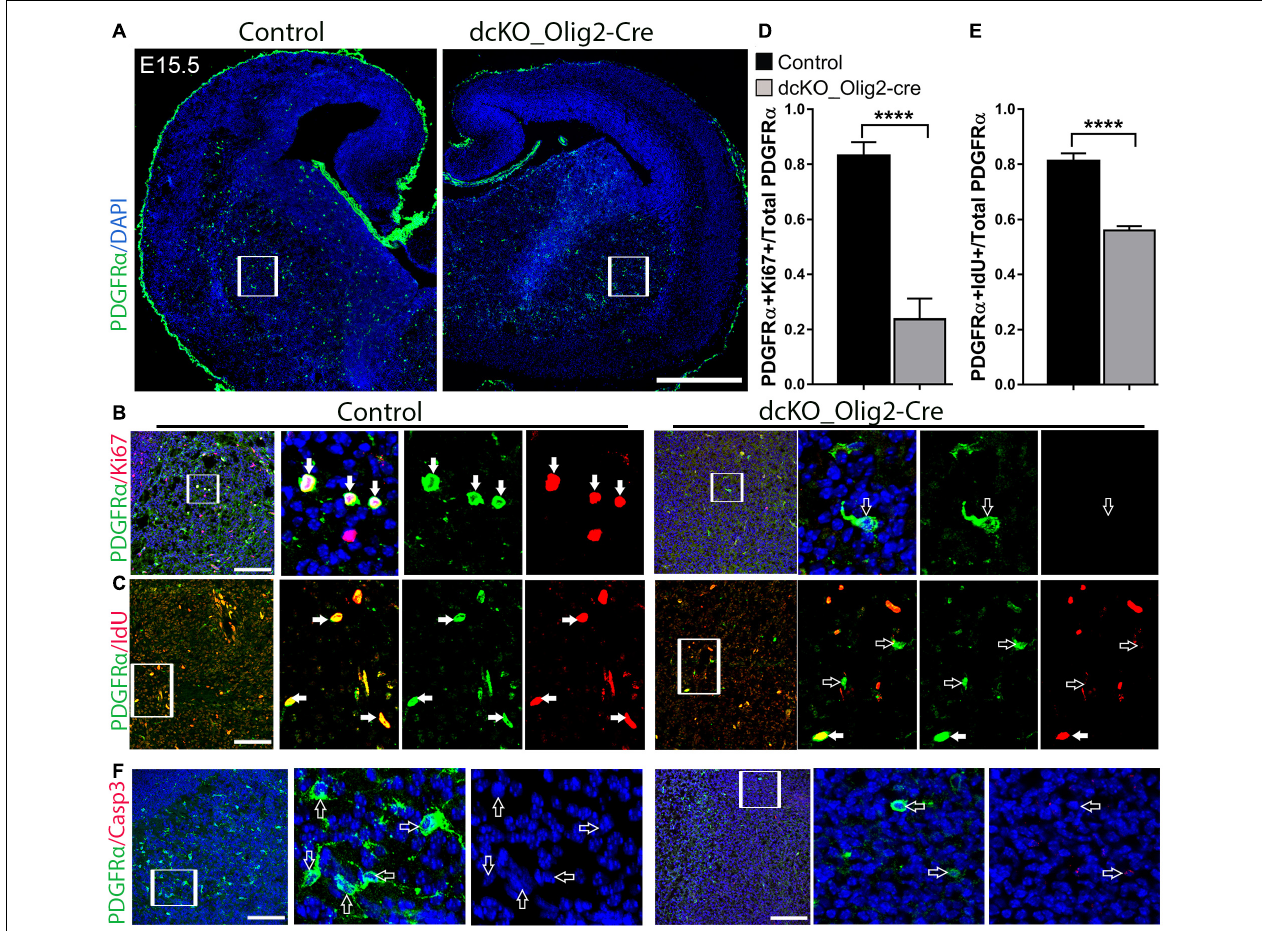
FIGURE 5 | Conditional removal of BAF155 and BAF170 leads to an impaired proliferative capacity of OPCs. (A) Images showing immunostaining of PDGFR α -labeled oligodendrocyte precursor cells in the dcKO E15.5 forebrains compared with controls. (B,C) High magnification images of the outlined regions (inserted boxes) of the ventral telencephalon showing immunolabeling of PDGFR α and Ki67 (B) and PDGFR α and IdU (C) to mark proliferating oligodendrocyte precursor cells in the E15.5 control and mutant forebrain. Filled arrows show PDGFR α positive oligodendrocyte precursor cells expressing Ki67 or IdU, and empty arrows point to PDGFR α oligodendrocyte precursor cells negative for Ki67 or IdU. (D,E) Bar charts showing significant reduction of the ratio of PDGFR α + and Ki67 + per total PDGFR α + cells as well as the ratio PDGFR α + and IdU + per total PDGFR + cells in the dcKO_Olig2-Cre ventral telencephalon compared with control. (F) High magnification images showing PDGFR α , Sox10 (violet) and Casp3 immunostaining in the E15.5 ventral telencephalon. Empty arrows point to PDGFR α + and Sox10 + cells lacking Casp3 expression. Data are presented as means ± SEMs; **** p ≤ 0.0001; Experimental replicates ( n ) = 6. Scale bars = 200 µ m (A) , 50 µ m (B,C,F)